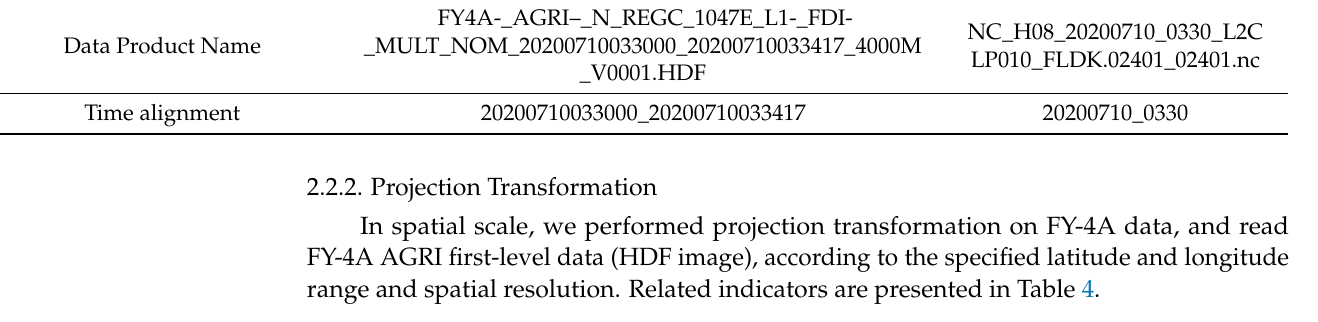
Table 4. FY-4A-related indicators of National Satellite Meteorological